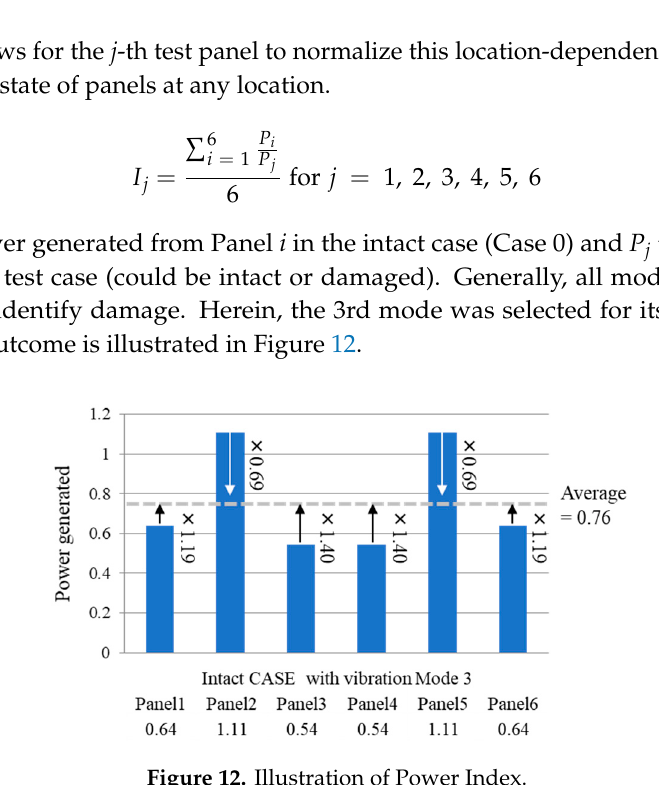
Figure 12. Illustration of Power Index.